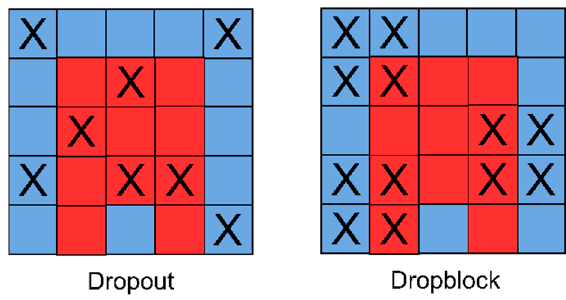
Figure 8. Schematic of Dropout and